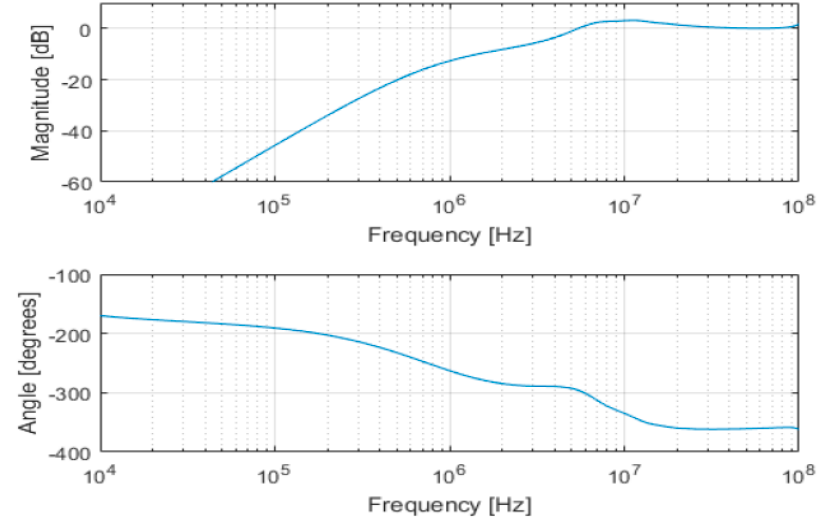
Figure 5. VCO to output transfer functions.